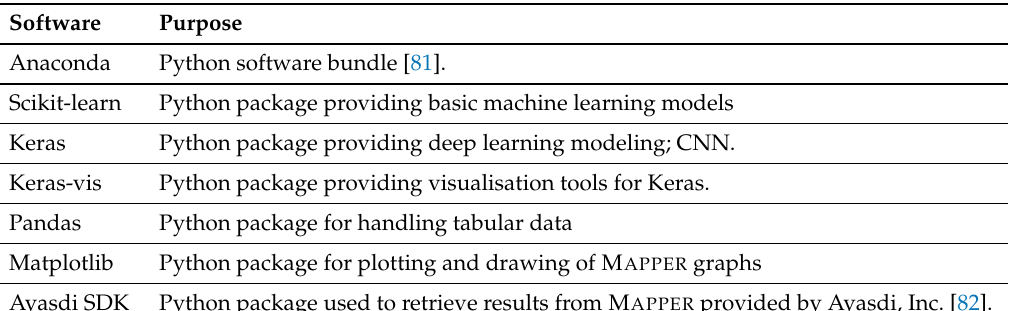
Table A3. Software used in the experiments.